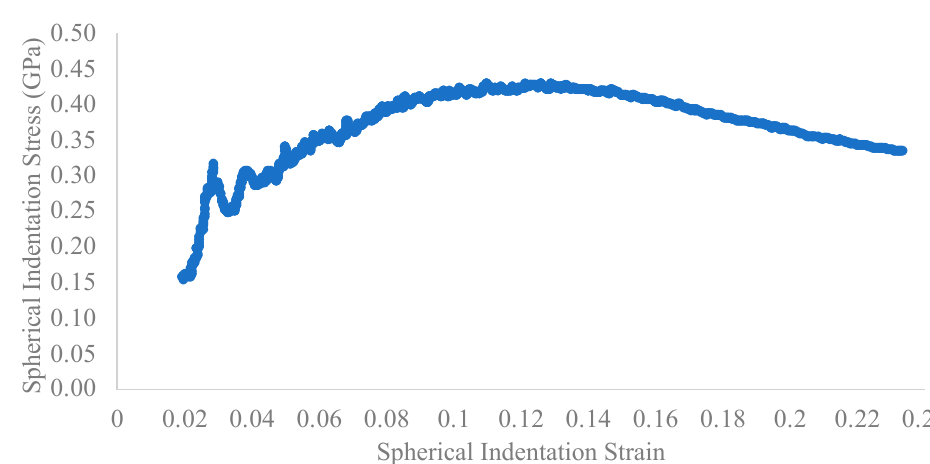
Figure 34. Spherical nanoindentation stress–strain curve for Al 6061 powder obtained by way of CSM-based analysis.